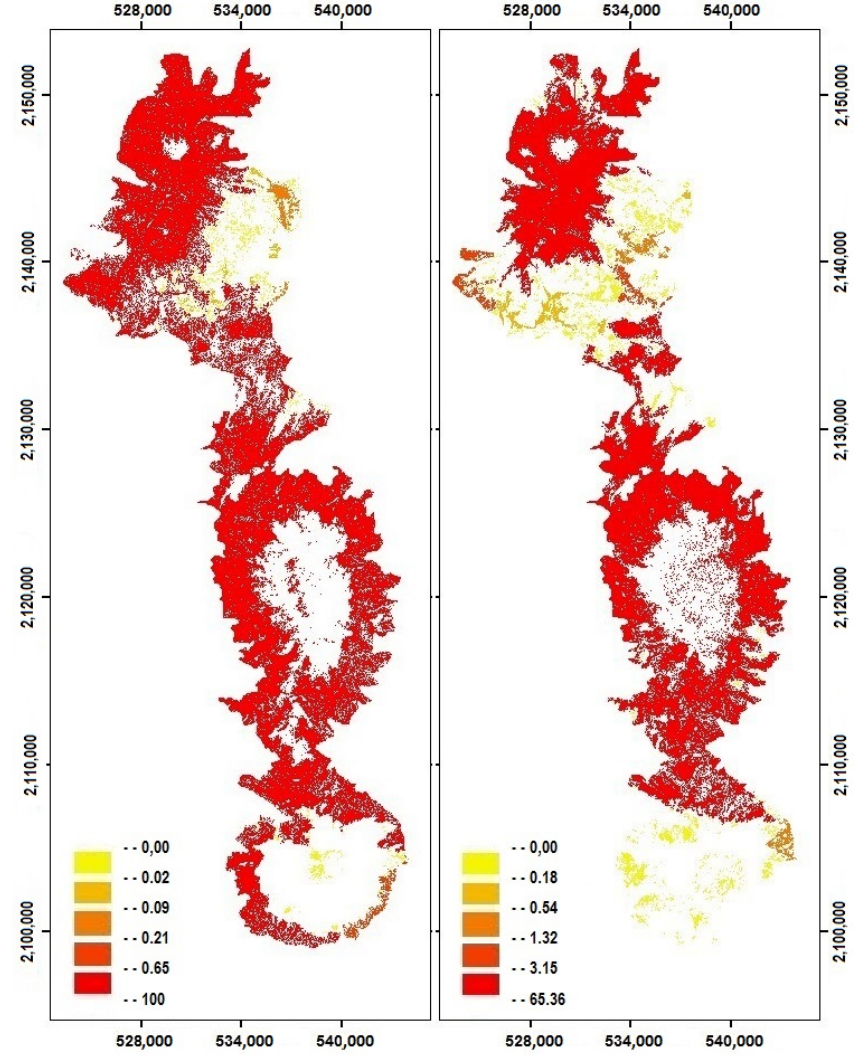
Figure 3. The dCP Values (5) for 1993 ( left ) and 2013 ( right ) calculated on the P. hartwegii remote sensing data-classified habitats, with a dispersal distance of 52.72 m.